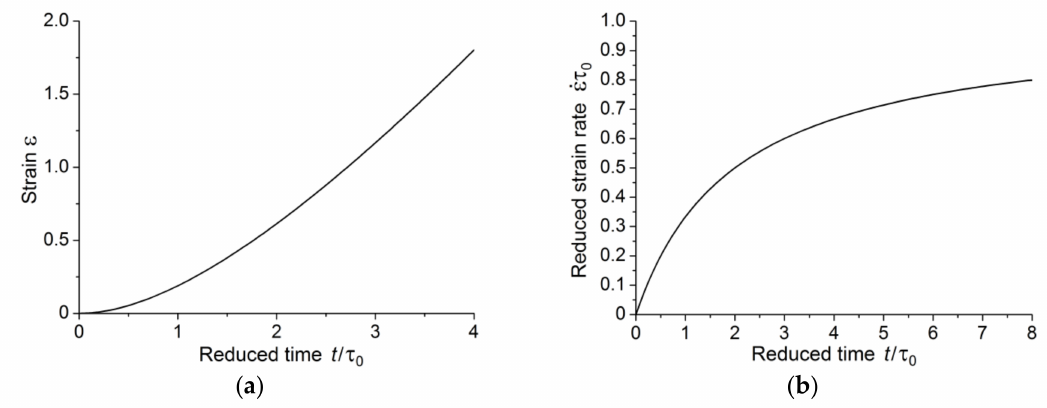
Figure 4. Variations in creep strain ε ( a ) and reduced strain rate normalized time τ at normalized stresses D = 0.1 (1), D = 0.2 (2), and D = 0.3 (3) lower than the critical value 0.5 ( a < a ∗ ).